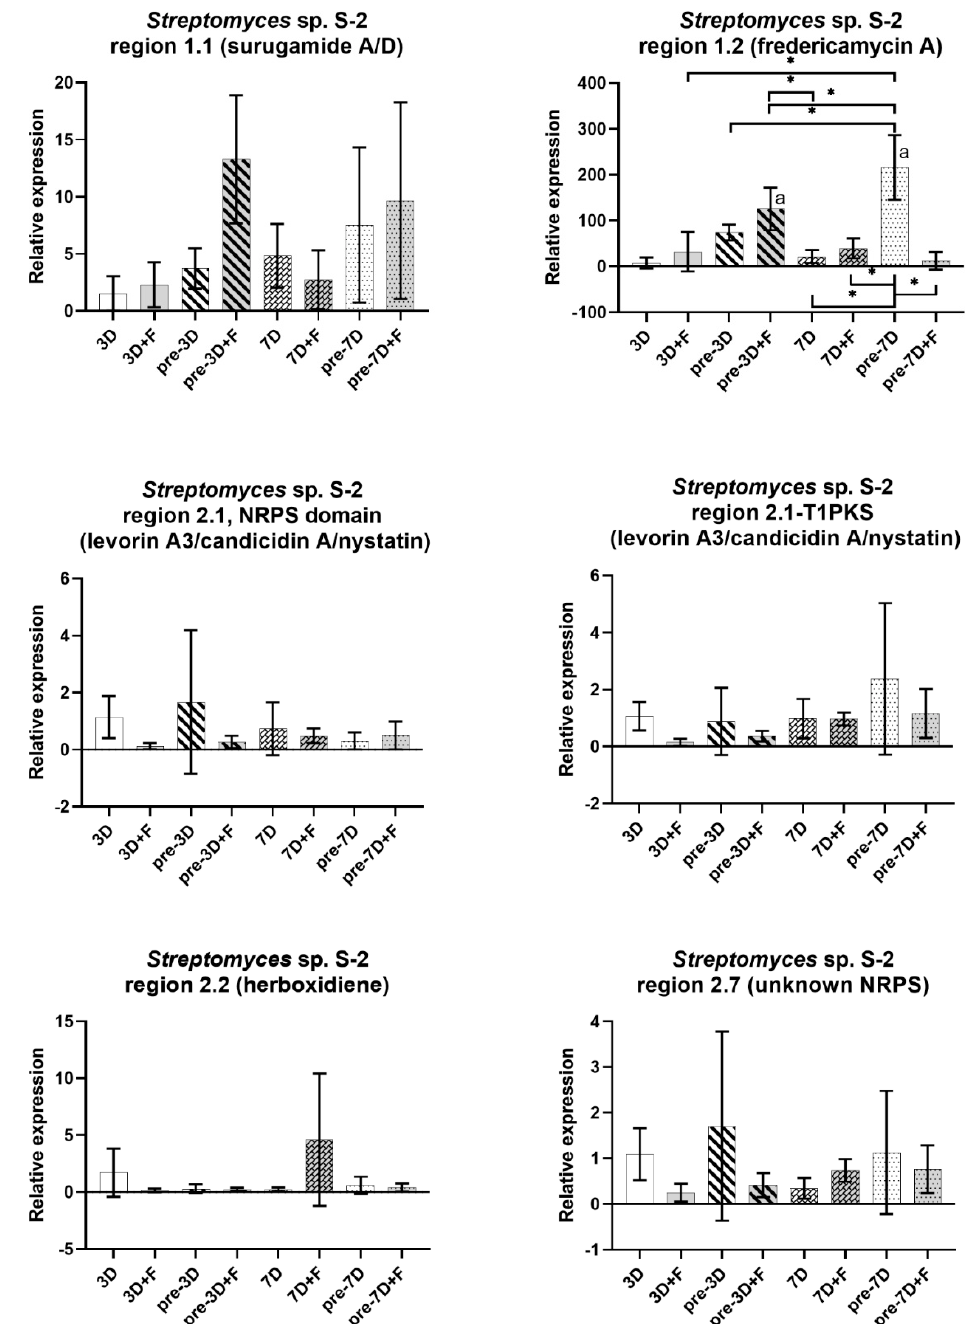
Figure 8. Relative expression of selected BGCs of Streptomyces sp. S-2 grown as a single culture (3D, pre-3D, 7D, and pre-7D) or in co-culture with F. culmorum DSM62188 (3D + F, pre-3D + F, 7D + F, and pre-7D + F). The strain was cultured in simultaneous (3D and 7D) cultures or with the pre-cultured Streptomyces strain for 3 (pre-3D) or 7 (pre-7D) days. The qPCR was performed on mRNA samples purified from cultures at the 3rd (3D; 3D + F), 6th (pre-3D; pre-3D + F), 7th (7D; 7D + F), and 14th (pre-7D; pre-7D + F) day of incubation. For each sample, two culture plates were used for mRNA purification,